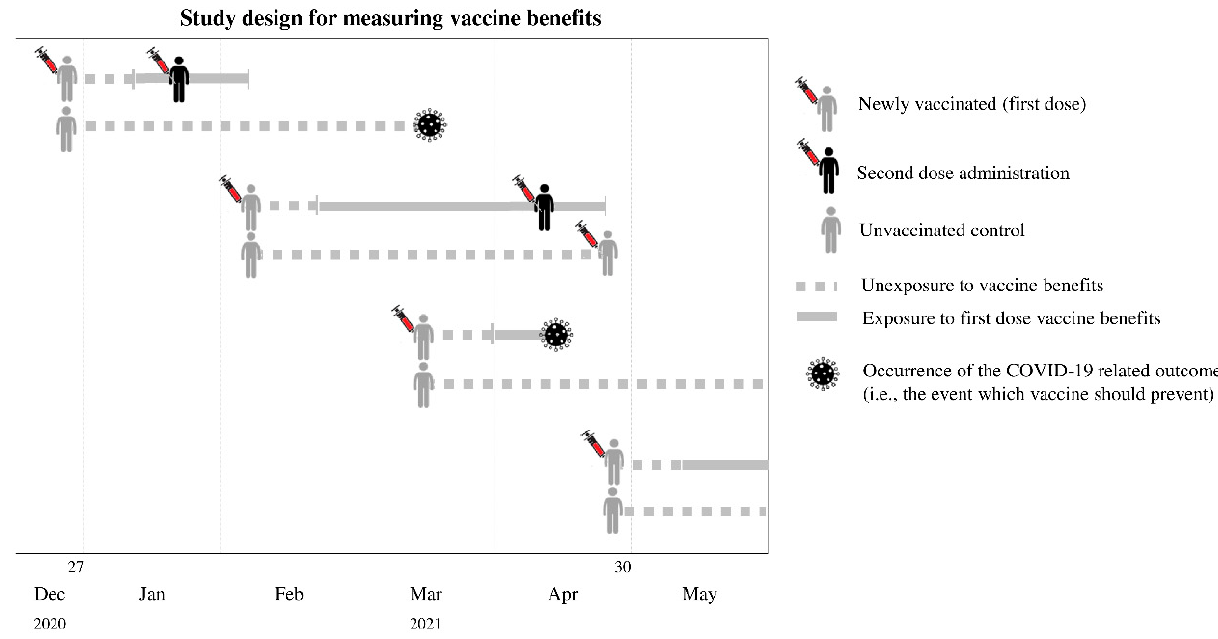
Figure 1. Study design for measuring vaccine benefits.